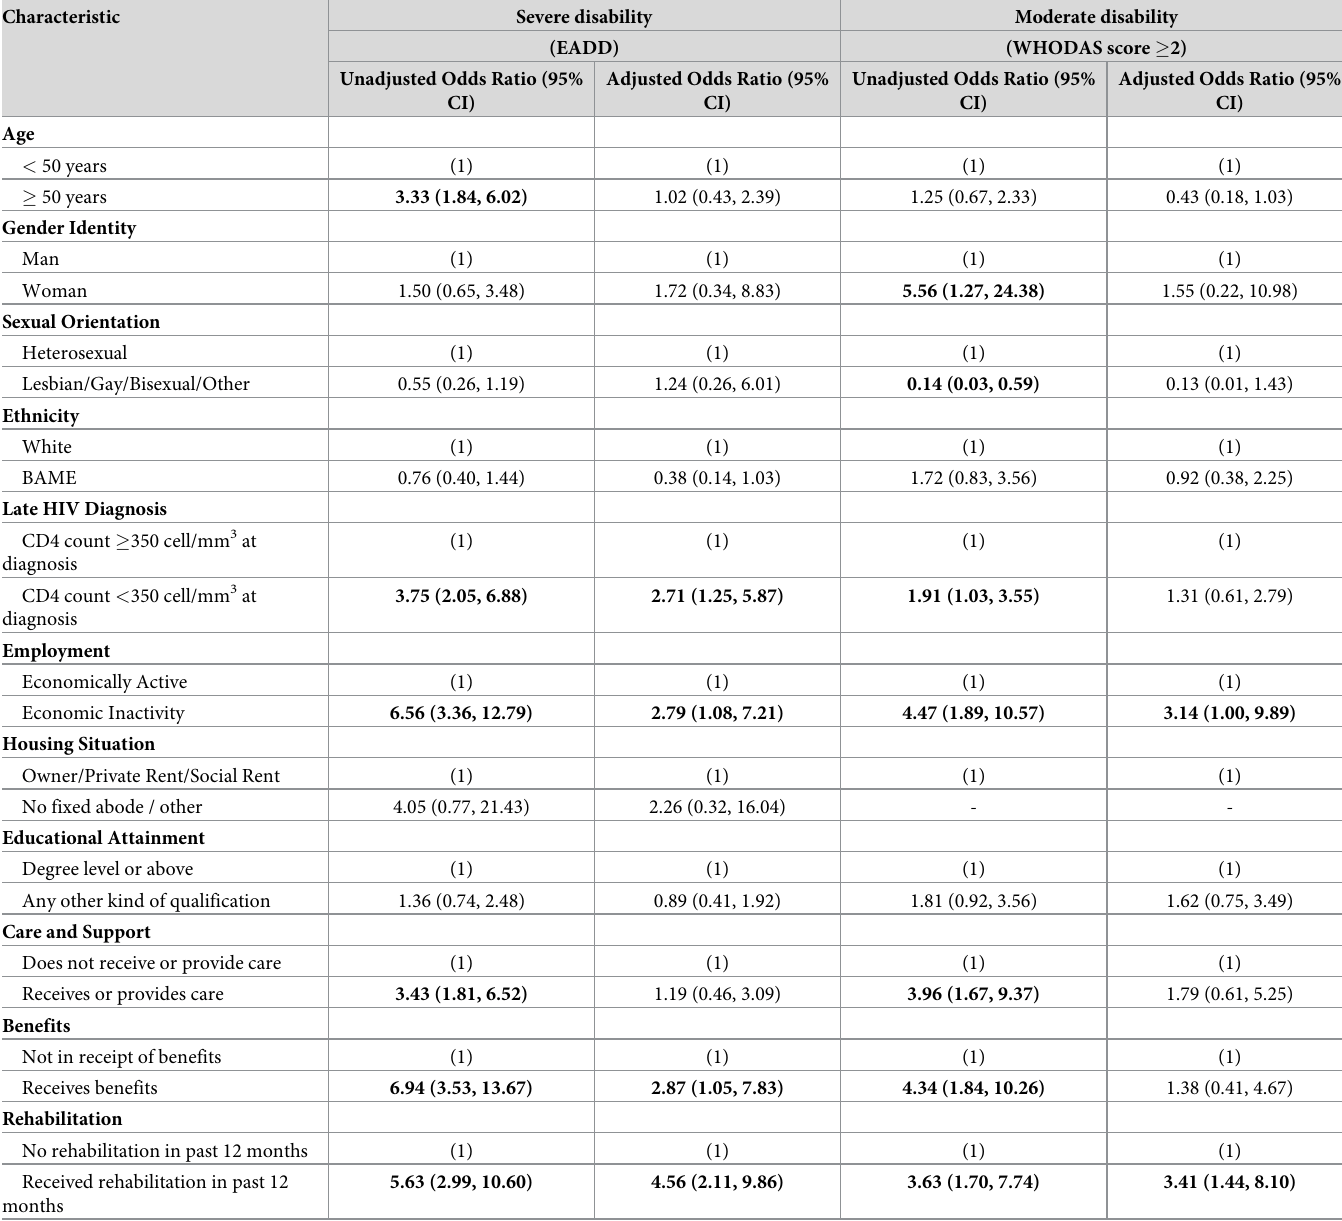
Table 3. Potential risk factors as predictors of severe or moderate